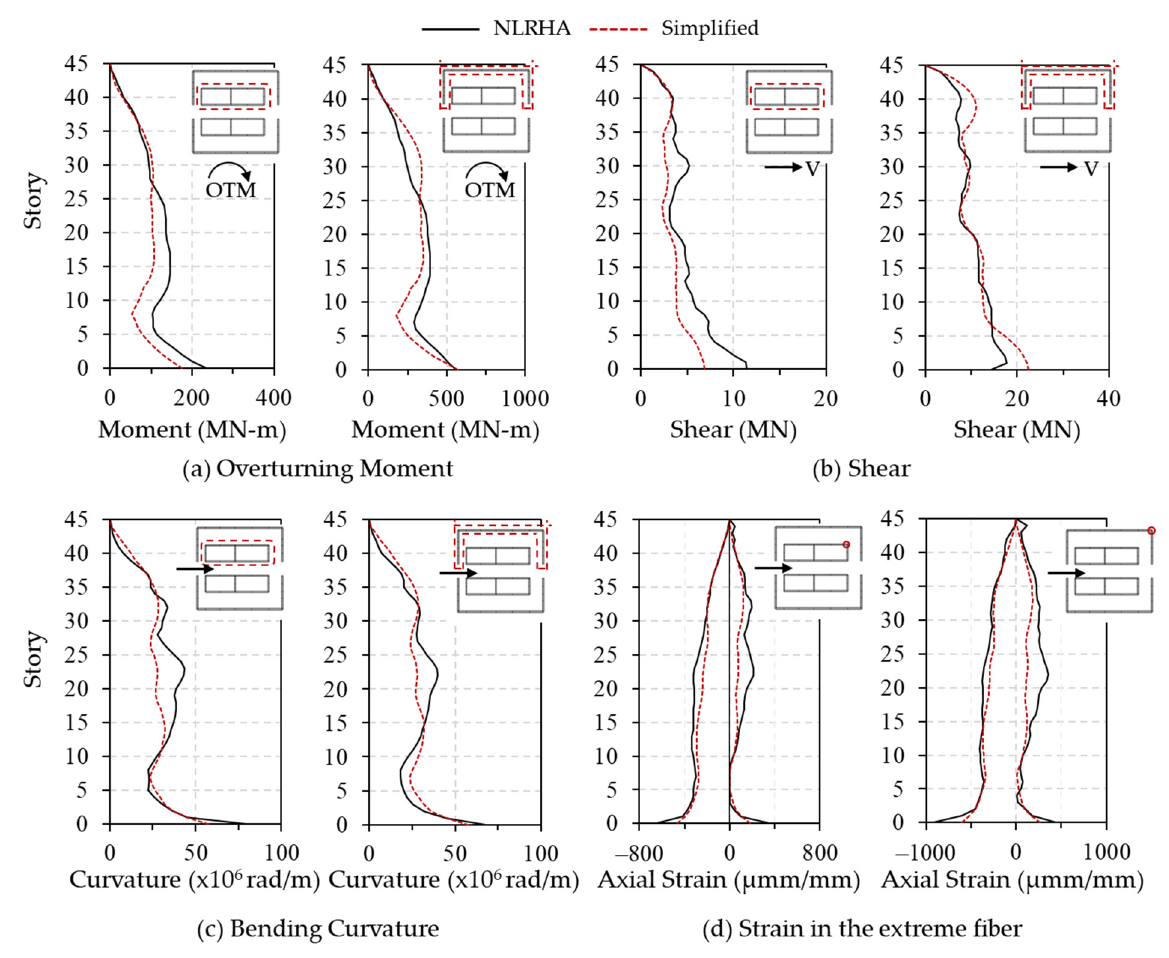
Figure 18. Comparison of the component level responses caused by EQ1 in the x direction for build- ing B3 using the simplified and NLRHA procedures.